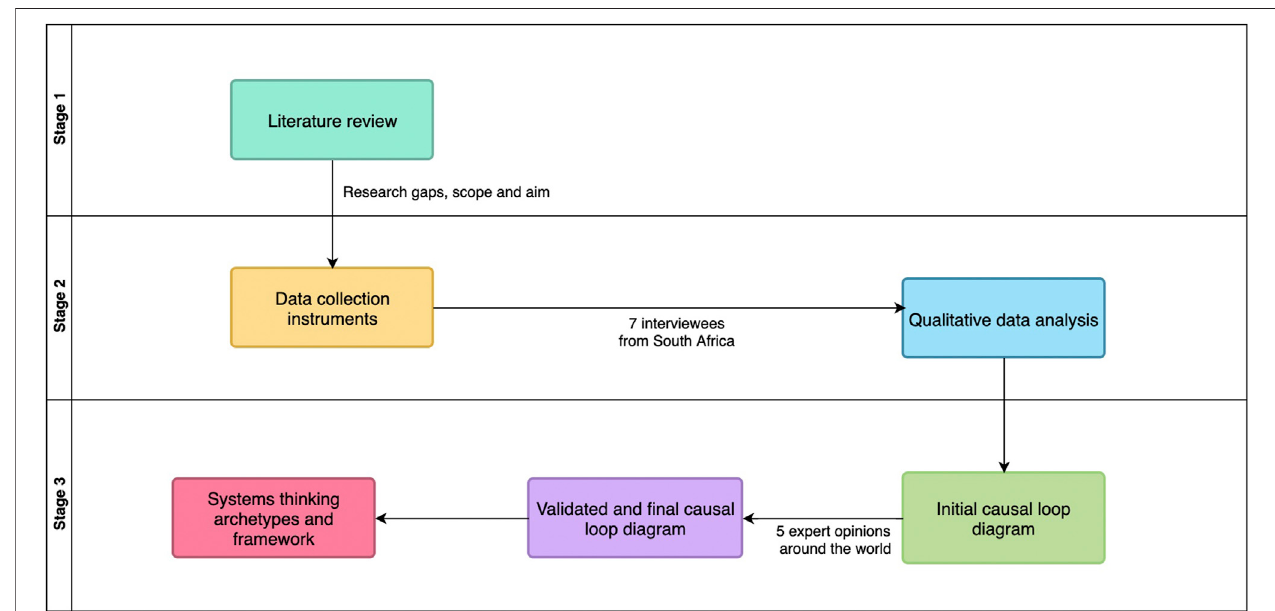
FIGURE 2 | Research protocol. Source: